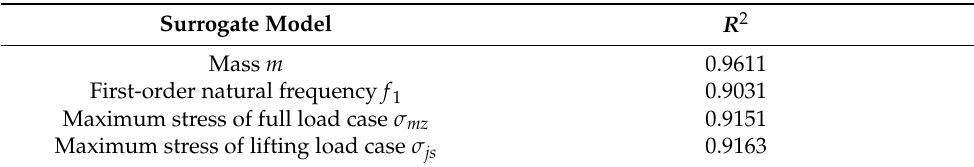
Table 4. Determination coefficients of surrogate